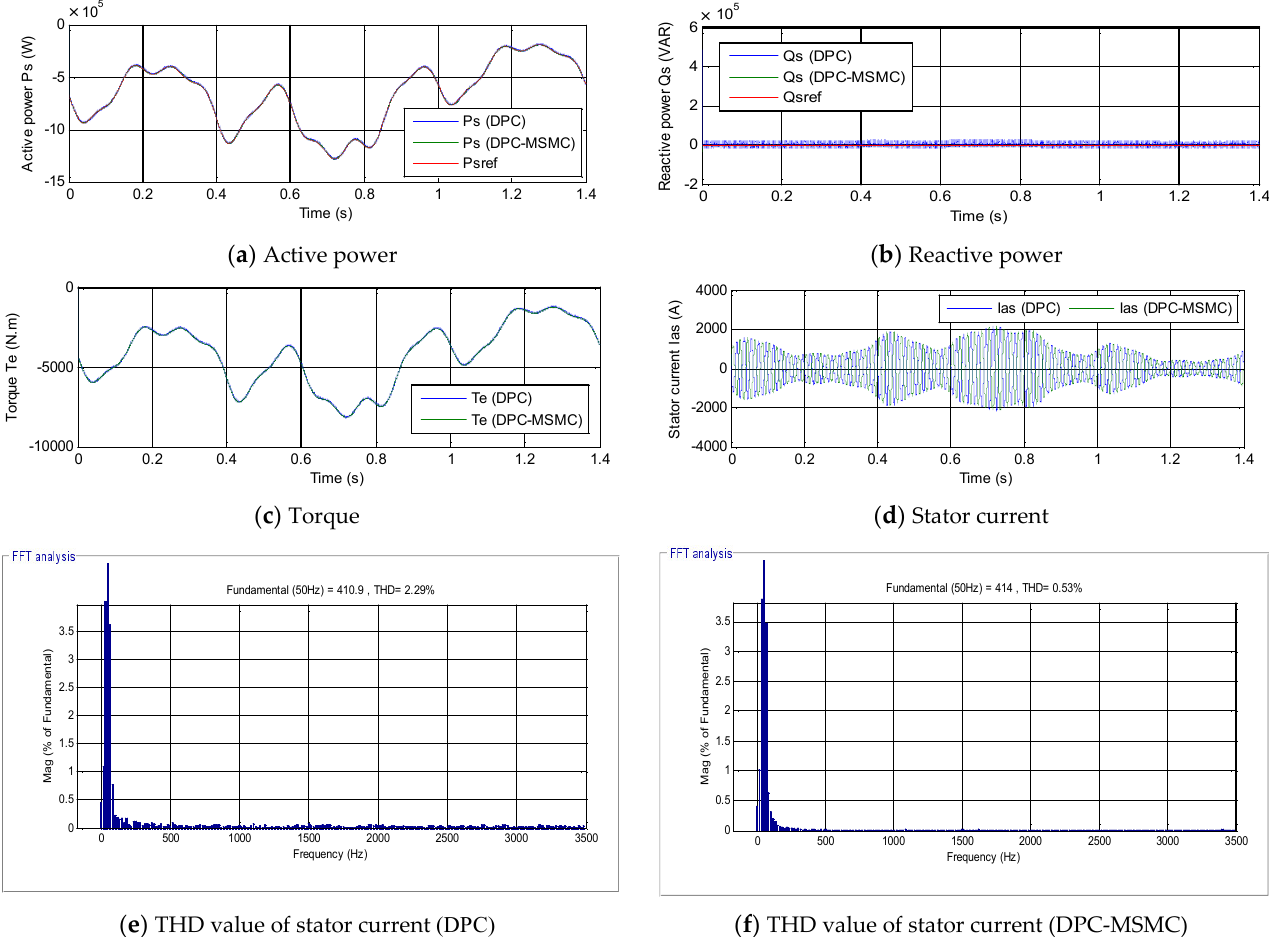
Figure 11. Simulated results from the robustness test.